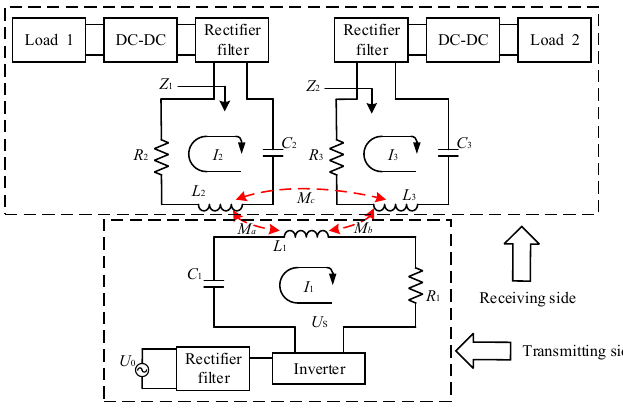
Figure 1. Equivalent circuit model of a dual-load cooperative coupling system.